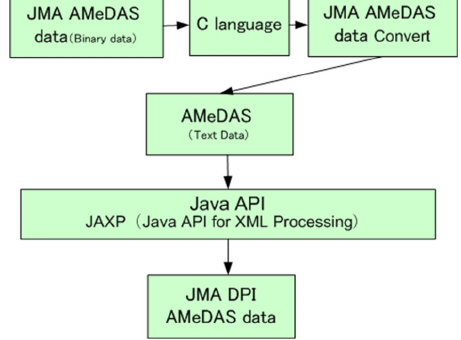
Figure 7. Flow of AMeDAS data format conversion